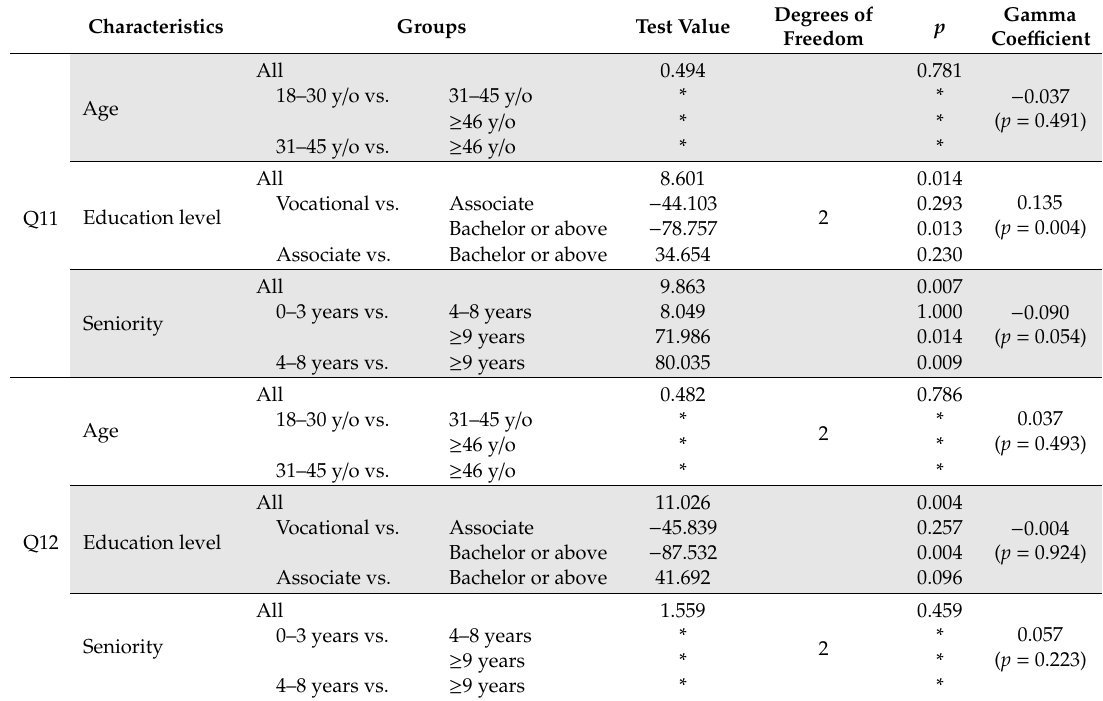
Table 4. Di ff erences between age, education level, and seniority groups for Q11 (benefits of traditional practice) and Q12 (benefits of continuing